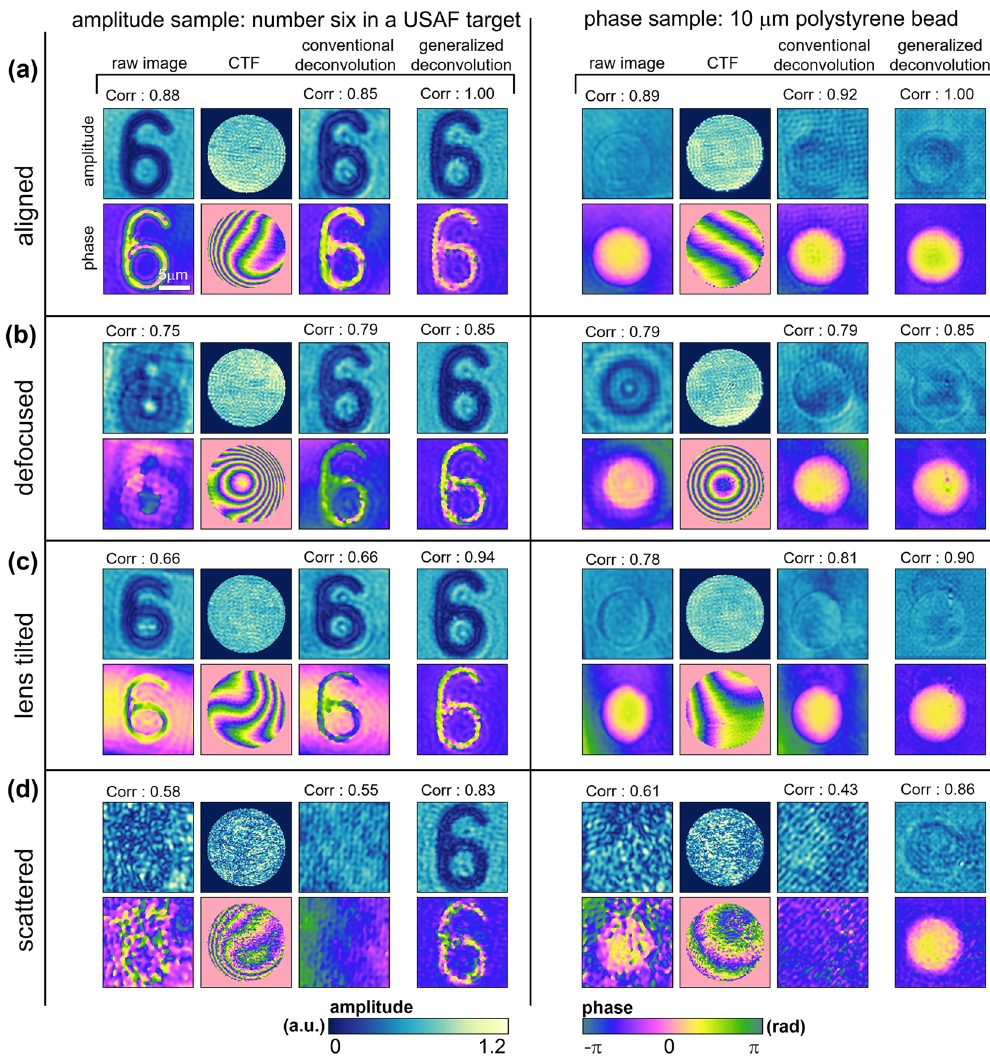
Figure 5. Reconstruction of distortion-free optical fields of an amplitude and a phase target. Retrieved optical field of a USAF target and 10- μ m-diameter polystyrene bead from the raw holograms, the restored optical fields of the targets using both conventional and generalized deconvolutions, and the CTF of the optical configuration in ( a ) aligned, ( b ) defocused, ( c ) lens tilted, and ( d ) scattered imaging conditions. For each complex optical field image, the value of the field-field correlation with the optically aligned condition is also